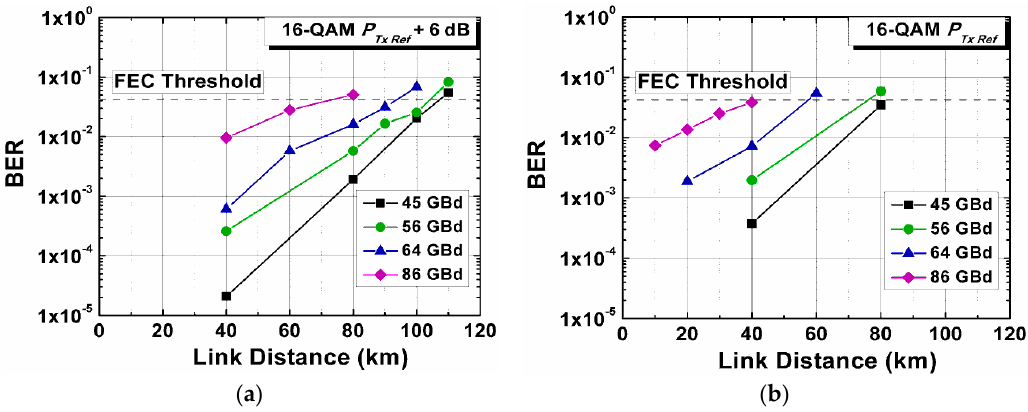
Figure 6. BER as a function of transmission distance in unamplified point-to-point link for 16-QAM signals with ( a ) 6-dB more transmitter output power than the reference point; ( b ) transmitter output power at the reference point.